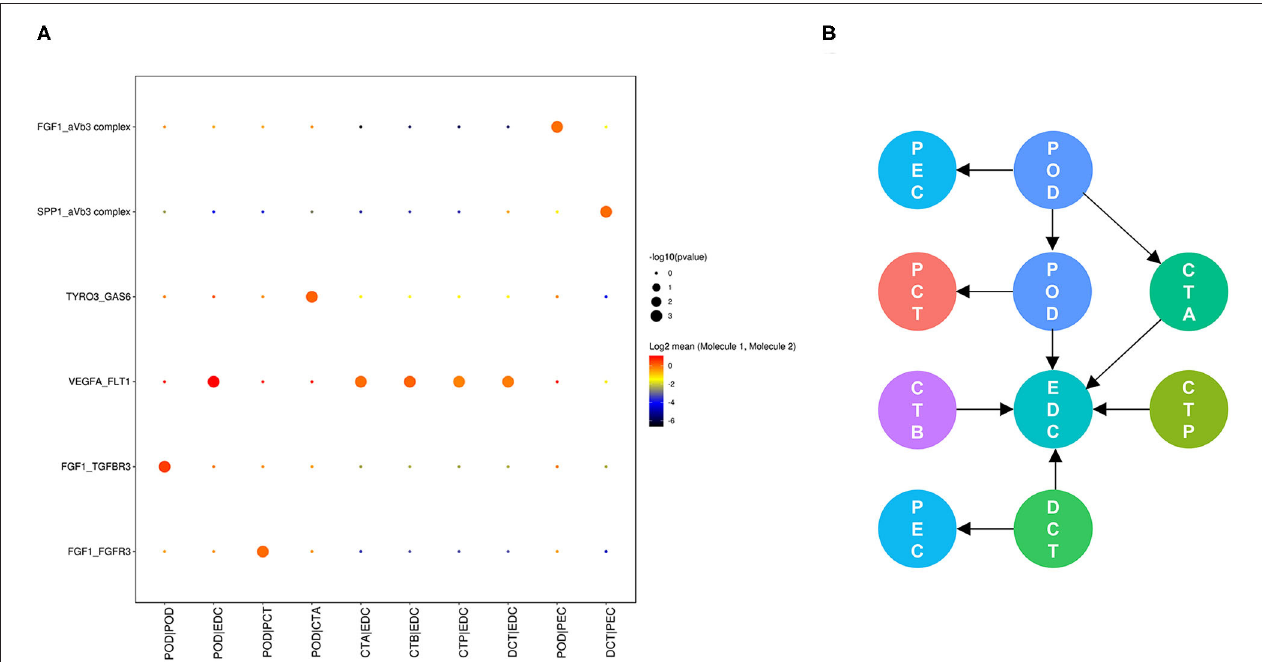
FIGURE 4 | Cell cross-talk in the kidneys of nondiabetic patients. We analyzed all individual cells based on ligand-receptor interactions to reveal the cell cross-talk in the kidneys of nondiabetic patients (A) . The involved cell types are summarized and the thickness of the arrow represents the number of interactions (B) .